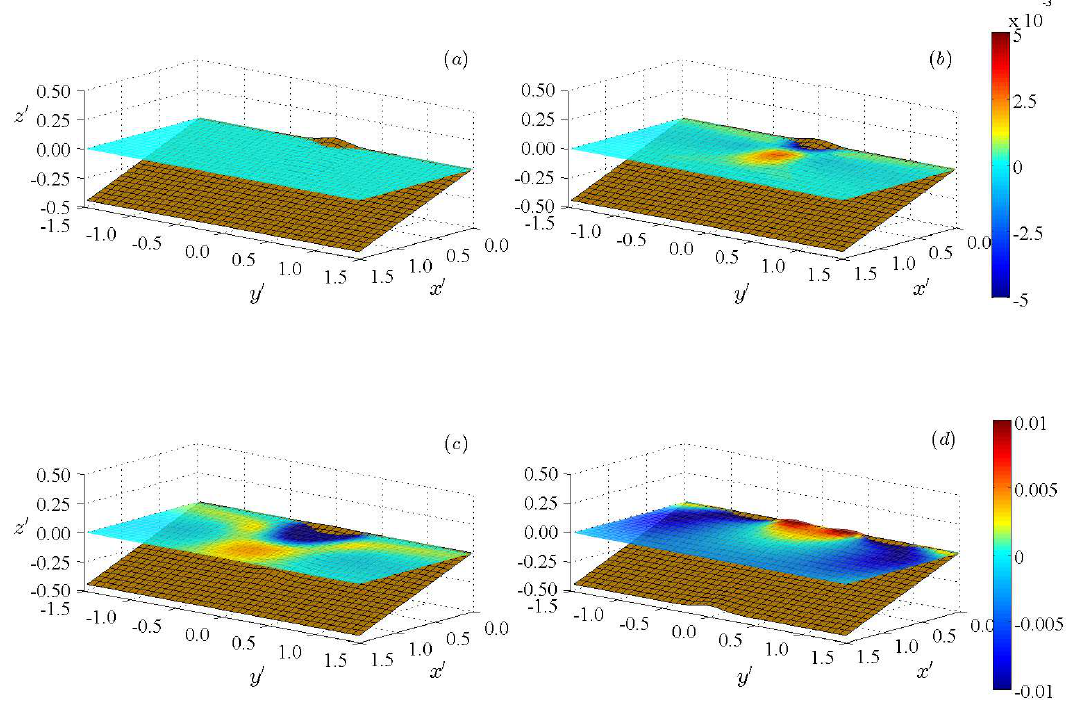
Fig. 6. Snapshots of the free-surface profile in physical variables at times: (a) t 0 = 0 s, (b) t 0 = 0 . 2 s (corresponding to t = 0 . 5), (c) t 0 = 0 . 5 s ( t = 1 . 5) and (d) t 0 = 1 . 5 s ( t = 4 . 5). The double Gaussian landslide of parameters c g = 2, x 0 g = 0 m, u 0 g = 1 m s − 1 is taken as reference model. The first six modes have been considered. All values are in metres.